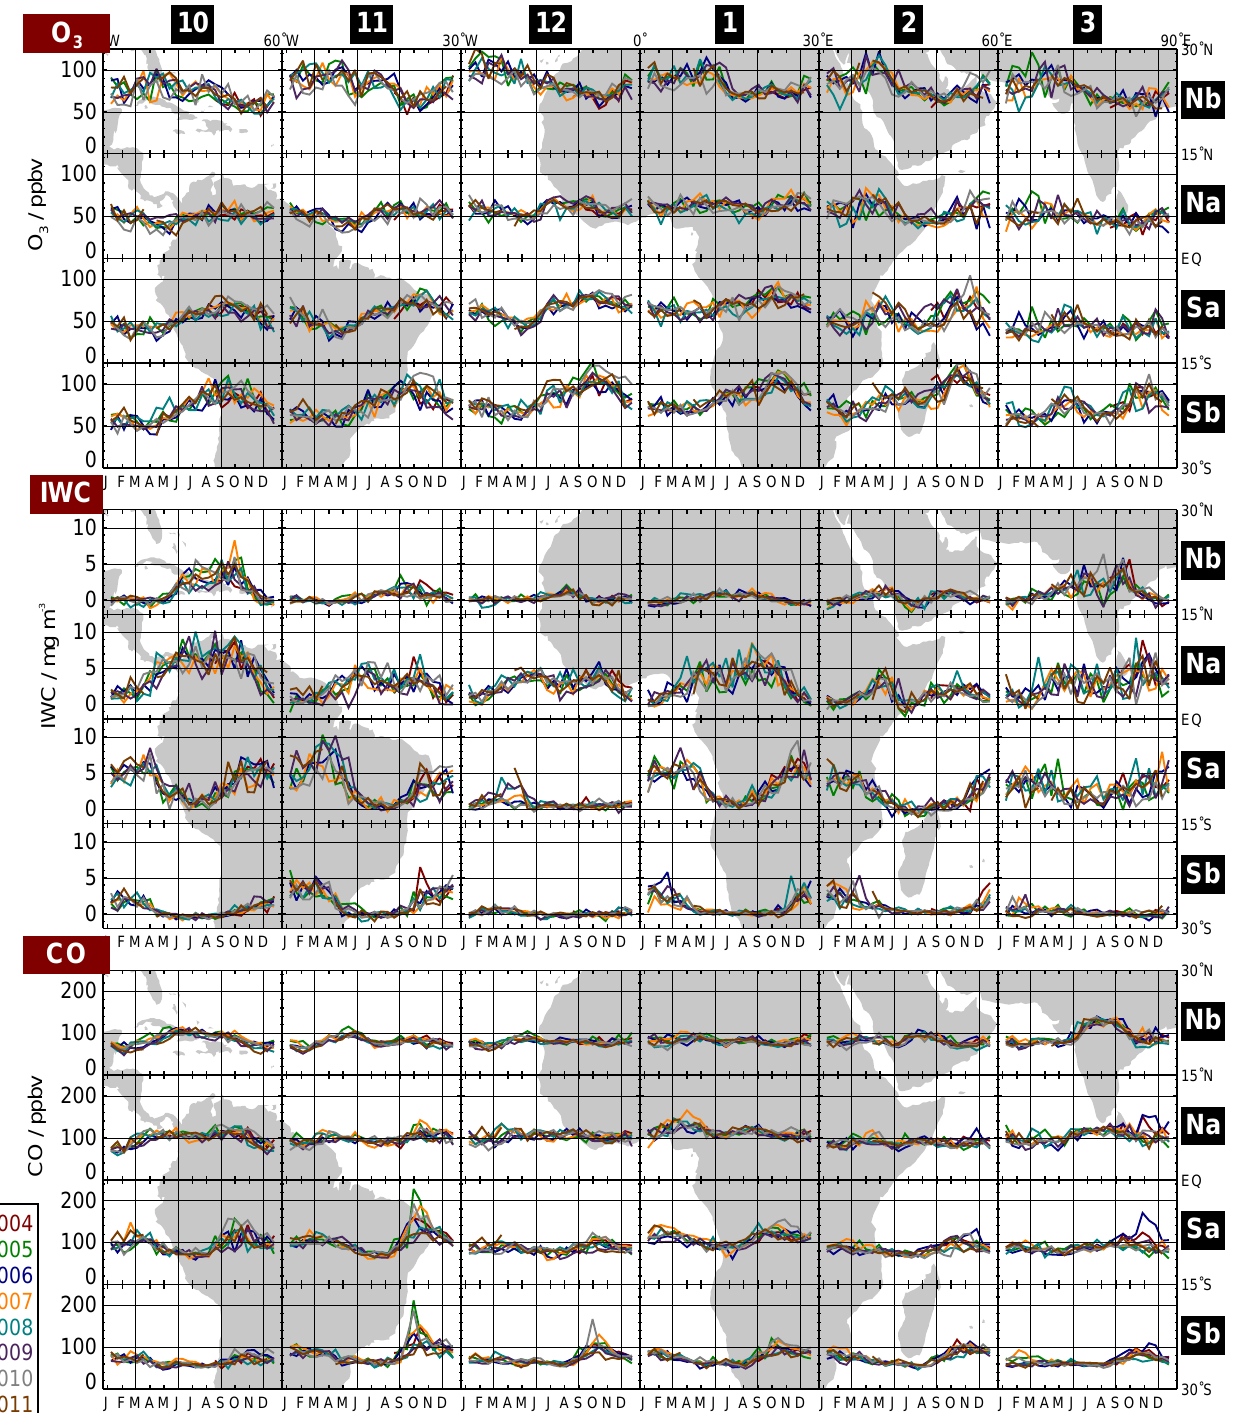
Fig. 1. MLS 215hPa O 3 (upper), cloud ice (middle, indicative of convection), and CO (lower) observations from 90 ◦ W to 90 ◦ E. Each cell shows timeseries of biweekly averages of MLS measurements in the geographic region covered by the cell. Line colors denote year, as shown in the legend at the bottom left. Numbers and letters in black boxes along the top and right edges identify regions for discussion in the text (e.g., 3Nb is the box encompassing much of